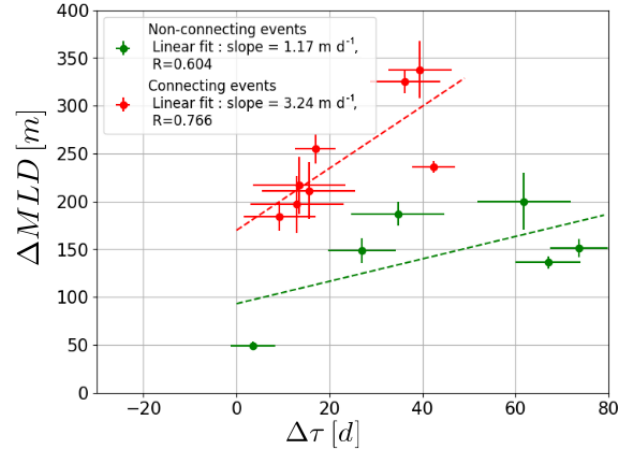
Figure 8. Scaling between the maximal MLD anomaly ( (cid:49) MLD) and restratification delay (cid:49)τ (see scheme in Fig. 3), distinguishing “connecting” (red) and “non-connecting” (green) events. Linear fit is applied separately, and correlation coefficient is put in the legend. Data and uncertainty are from Table